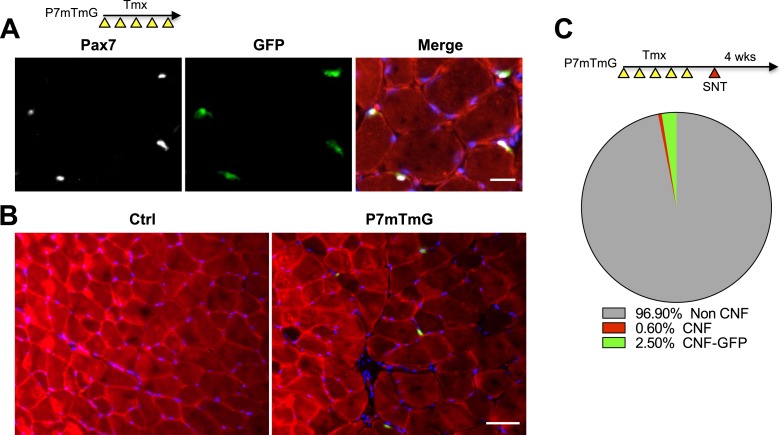
P7mTmG myofibers are not GFP + when examined immediately after Tmx administration.(A) Scheme demonstrating time of Tmx treatment, SNT surgery, and harvest of tissue. Representative images of adult P7mTmG TA muscle, taken 24 hr after Tmx treatment, sections stained for anti-GFP and anti-Pax7. (B) Images of Ctrl and P7mTmG TA muscle sections, note the lack of GFP + myofibers. (C) Proportion of central nucleated myofibers (CNF) and GFP + CNFs after SNT, 3875 myofibers examined.